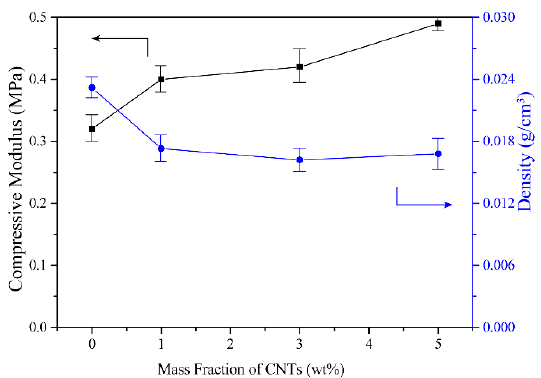
Figure 5. Compressive modulus and density of CMC / CNTs aerogels.